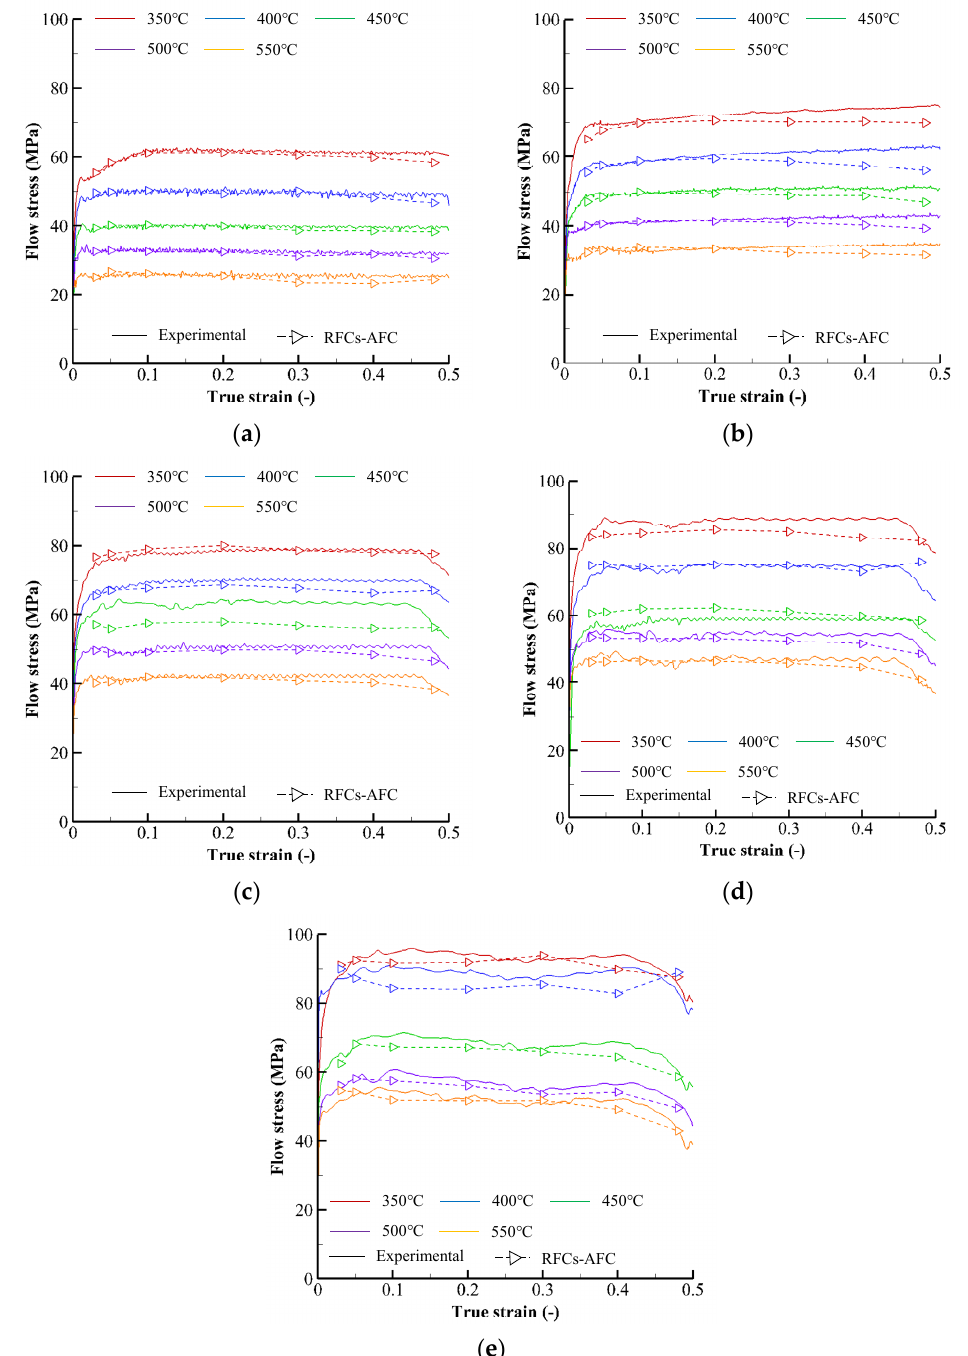
Figure 5. Primitive flow curves and RFCs–AFCs: ( a ) 0.1 s − 1 , ( b ) 1 s − 1 , ( c ) 5 s − 1 , ( d ) 10 s − 1 , and ( e ) 20 s − 1 . The predicted CLSCs by the RFCs–AFCs were compared with the experimental